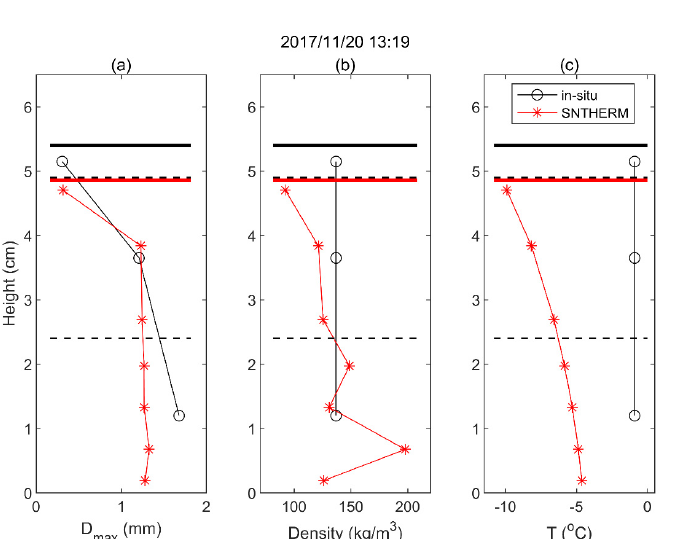
Figure 1. Time series change in snow depth, snow stratigraphy, and snow properties in the Altay dataset: ( a ) layered geometric grain size (D max ); ( b ) layered snow density; and ( c ) layered physical temperature (T).